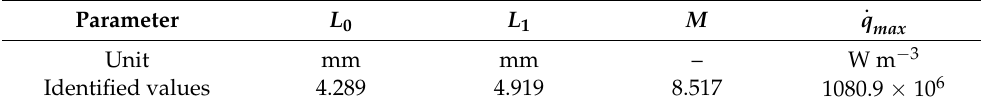
Table 4. Inversely identified parameters of the inductive heat source